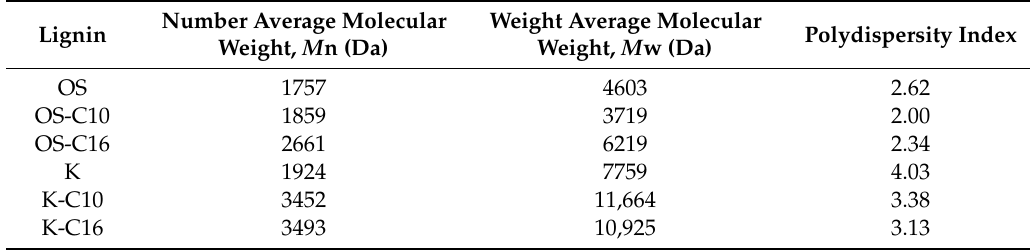
Table 3. Molecular weight values for non-functionalized organosolv (OS) and Kraft (K) lignin, as well as for their derivatives after etherification.